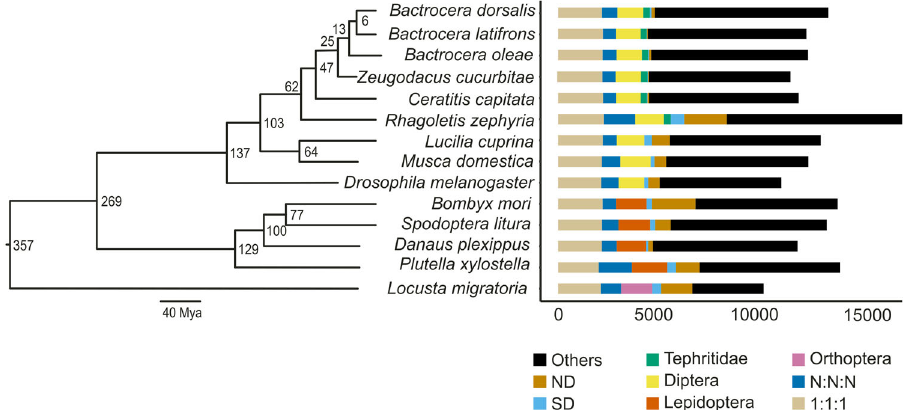
Fig. 2 Orthology and genome evolution of Bactrocera dorsalis compared with those of 13 other species. The 13 species used for comparison were B. latifrons , B. oleae , Zeugodacus cucurbitae , Ceratitis capitata , Rhagoletis zephyria , Drosophila melanogaster , Lucilia cuprina , Musca domestica , Bombyx mori , Spodoptera litura , Danaus plexippus , Plutella xylostella , and Locusta migratoria . IQ-TREE was used to construct the unrooted maximum-likelihood phylogenetic tree for the 14 species based on genomic data obtained using LG + F + I + G4 model for 1000 bootstrap replicates. The gene set of each species was subdivided into different types of orthology clusters. ‘ 1:1:1 ’ represents universal single-copy gene families across all examined species; ‘ N:N:N ’ indicates other universal genes; ‘ Orthoptera, ’ ‘ Lepidoptera, ’ ‘ Diptera, ’ and ‘ Tephritidae ’ indicate common gene families unique to Orthoptera, Lepidoptera, Diptera, and Tephritidae; ‘ S.D. ’ represents species-speci fi c duplication; ‘ N.D. ’ represents species-speci fi c